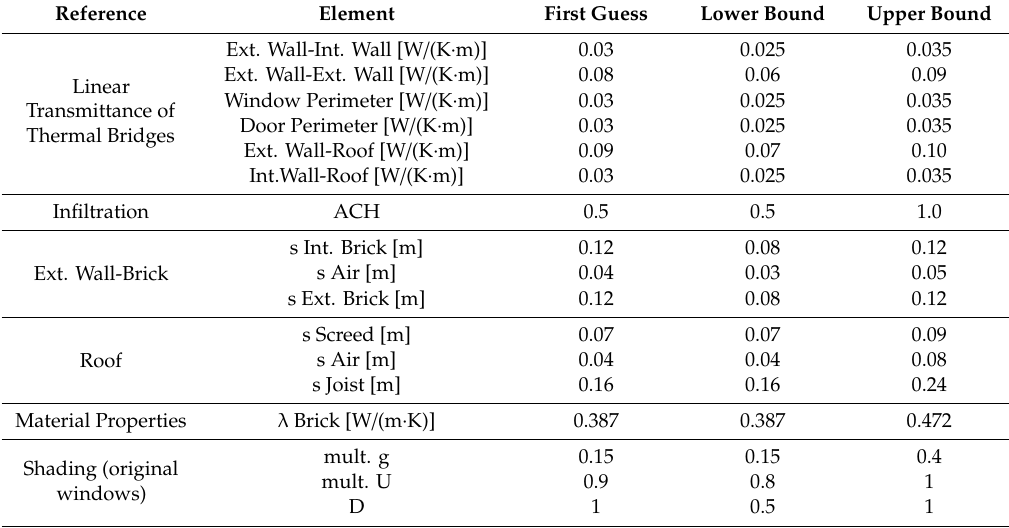
Figure 8. Results for Calibration A. First floor, North exposure. Table 6. Parameters collection for Calibration A *.